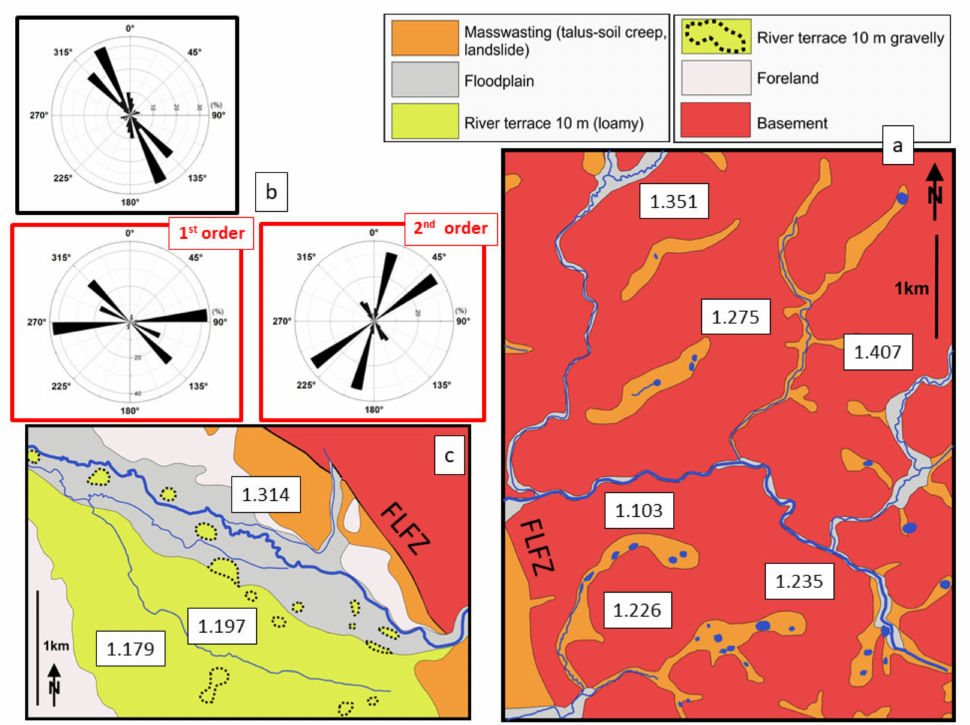
Figure 9. The litho- and morphotectonic unit (MTU) of the Schorgast drainage system characterized by the sinuosity (rectangular boxes) and the structural geology of the bedrock in LHG-type (see Figure 4). For legend see Figure 8 (160 data). ( a ) TA and CA of the Schorgast; ( b ) Fault zones (framed in black) in the MTU in comparison with the 1st (Schorgast River) and 2nd order streams systems the orientation of which are displayed in rose diagrams (percentage of total length of the drainage system); ( c ) DA of the Schorgast drainage